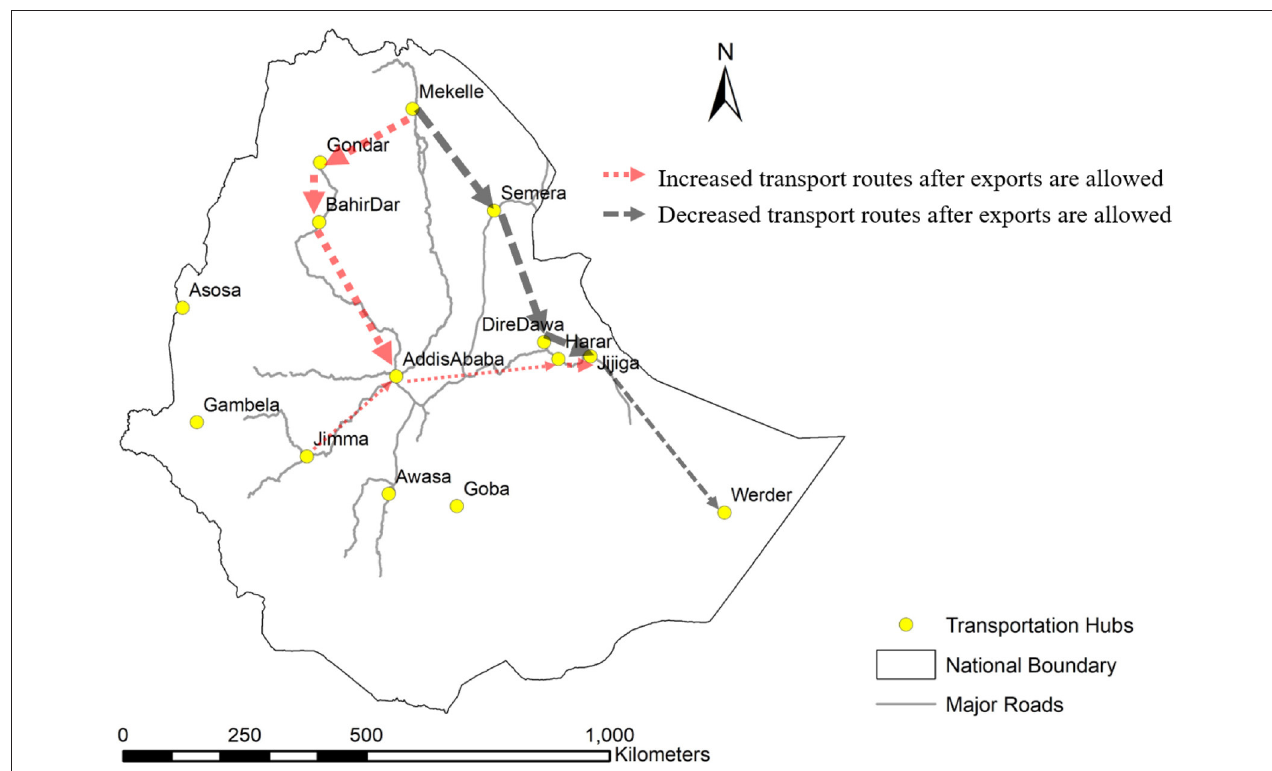
FIGURE 3 | Changes in teff transport pattern: The black lines correspond to the connections whose usage decreases after the ban is lifted. The red lines correspond to the connections whose usage increases after the ban is lifted. Thickness is proportional to magnitude of